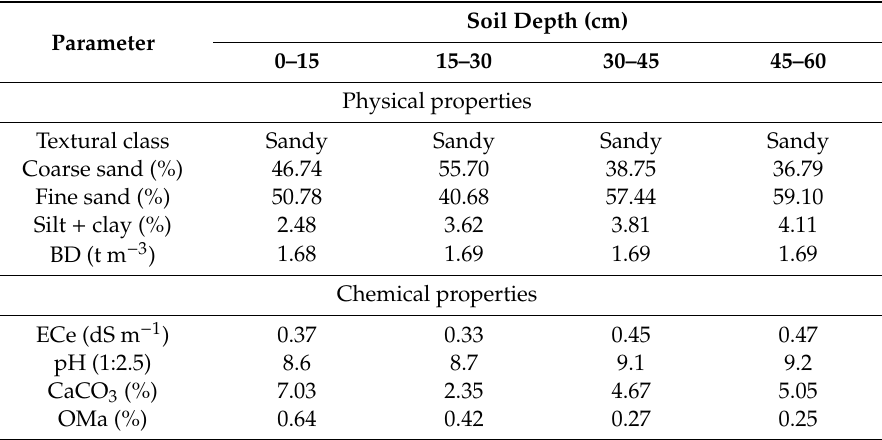
Table 2. Chemical and physical properties of the studied soil.